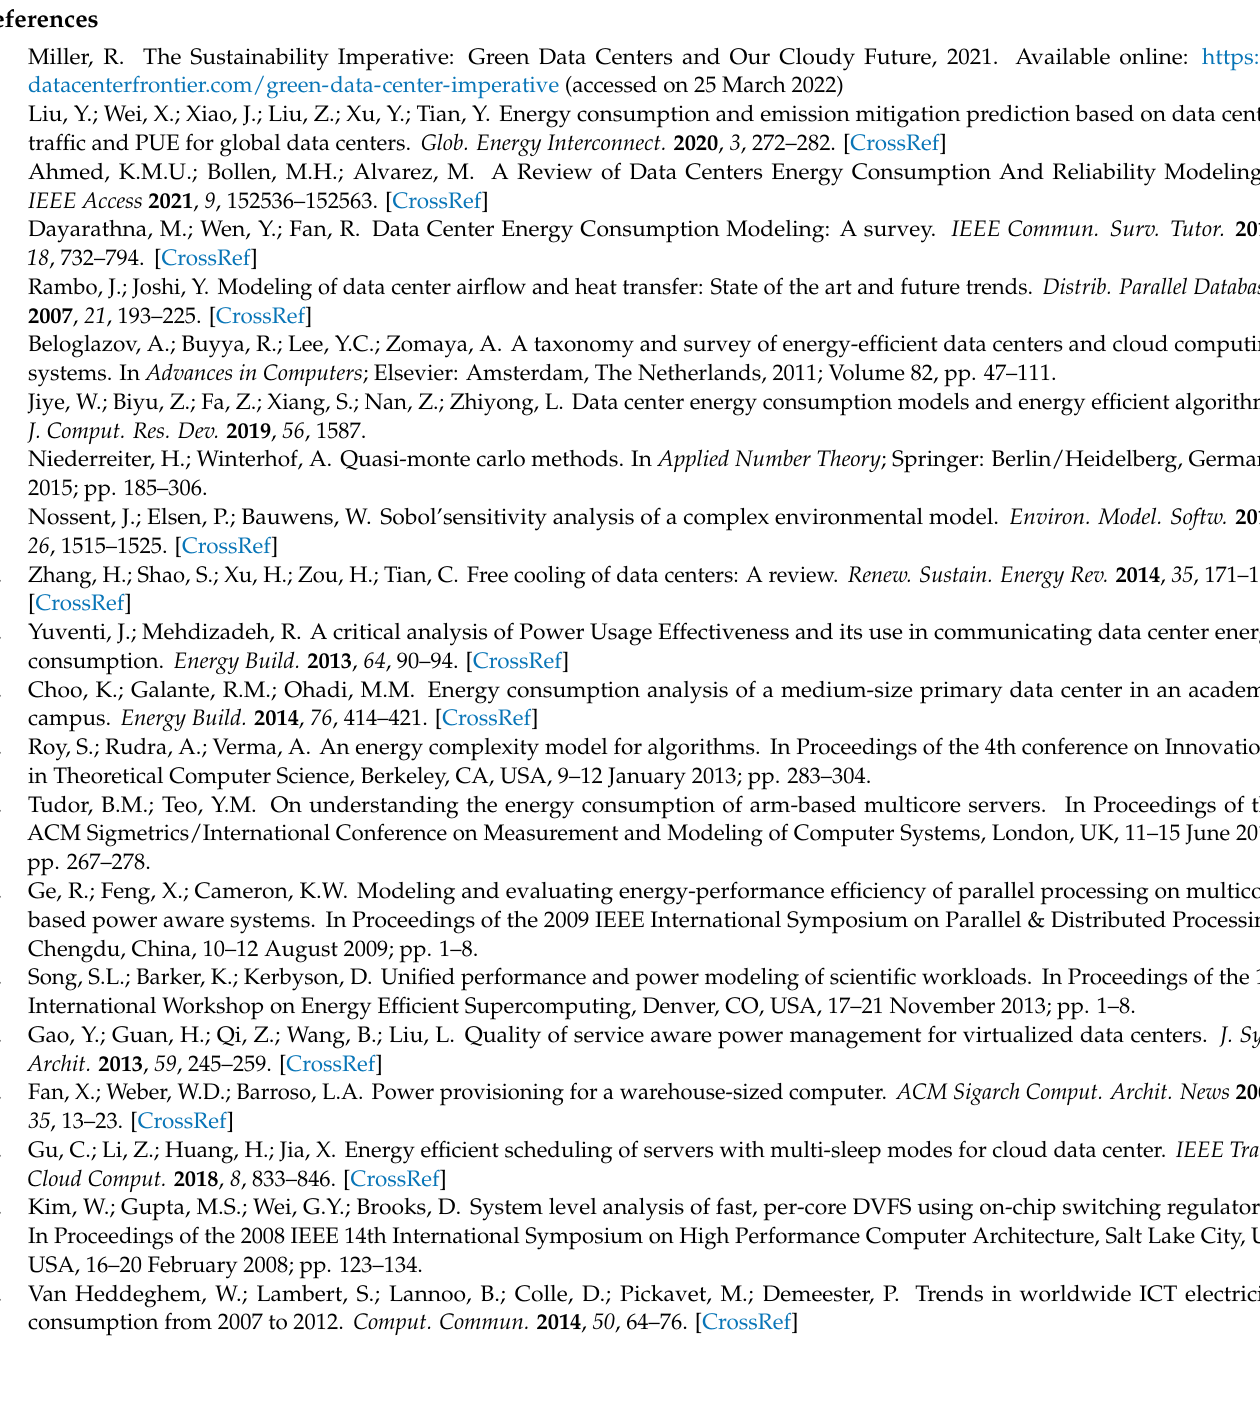
Figure A1. Annual PUE